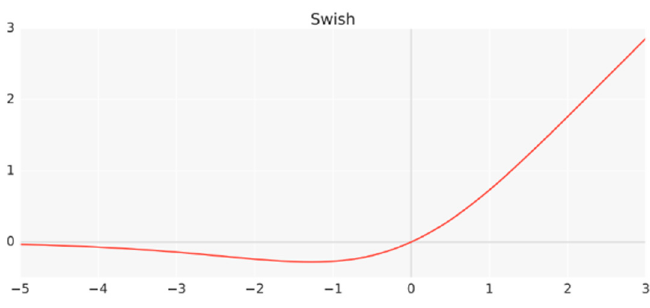
Figure 4. Swish activation function [55].